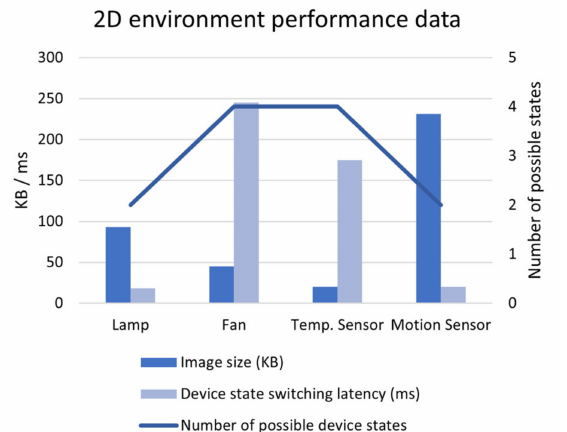
Figure 11. Two-dimensional environment performance results for each implemented virtual endpoint (lamp, fan, as well as temperature and motion sensors). Bars represent both image sizes (KB) and state switching latency (ms) per device, and the implicated axis is the left one. The line regards to the number of possible states that each device may assume, with scale in the right-hand